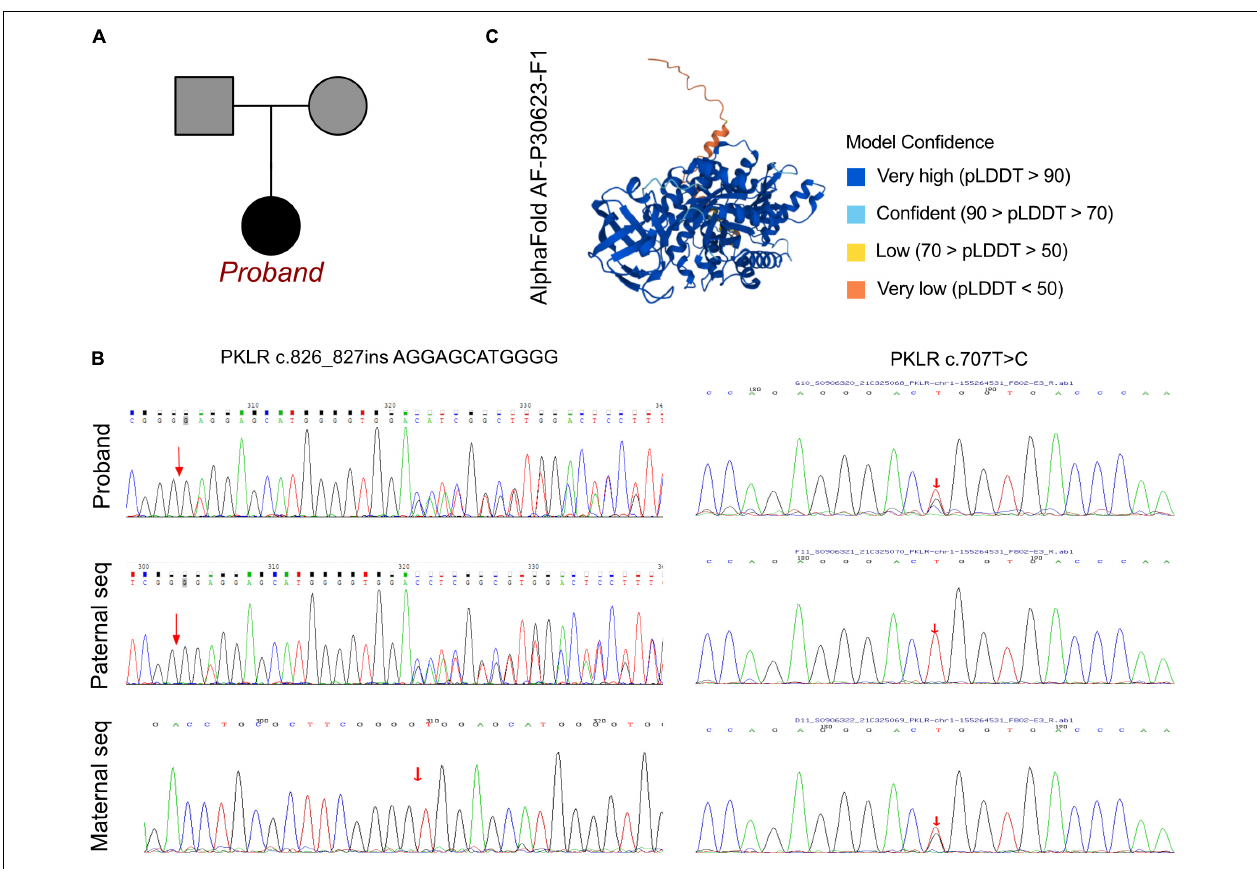
FIGURE 2 | The PKLR mutations in this family. (A) Family pedigree in the current proband. (B) Sanger sequencing validation of the current proband and his parents, revealing the maternal carrier of PKLR c.707T > C (p.L236R) and his paternal carrier of PKLR c.826_827insAGGAGCATGGG. The current proband exhibited PPHN and metabolic disorder in neonatal period and congenital non-spherocytic hemolytic anemia with a novel compound heterozygous mutation of PKLR . (C) The crystal structure of full length of AA sequence built by AlphaFold